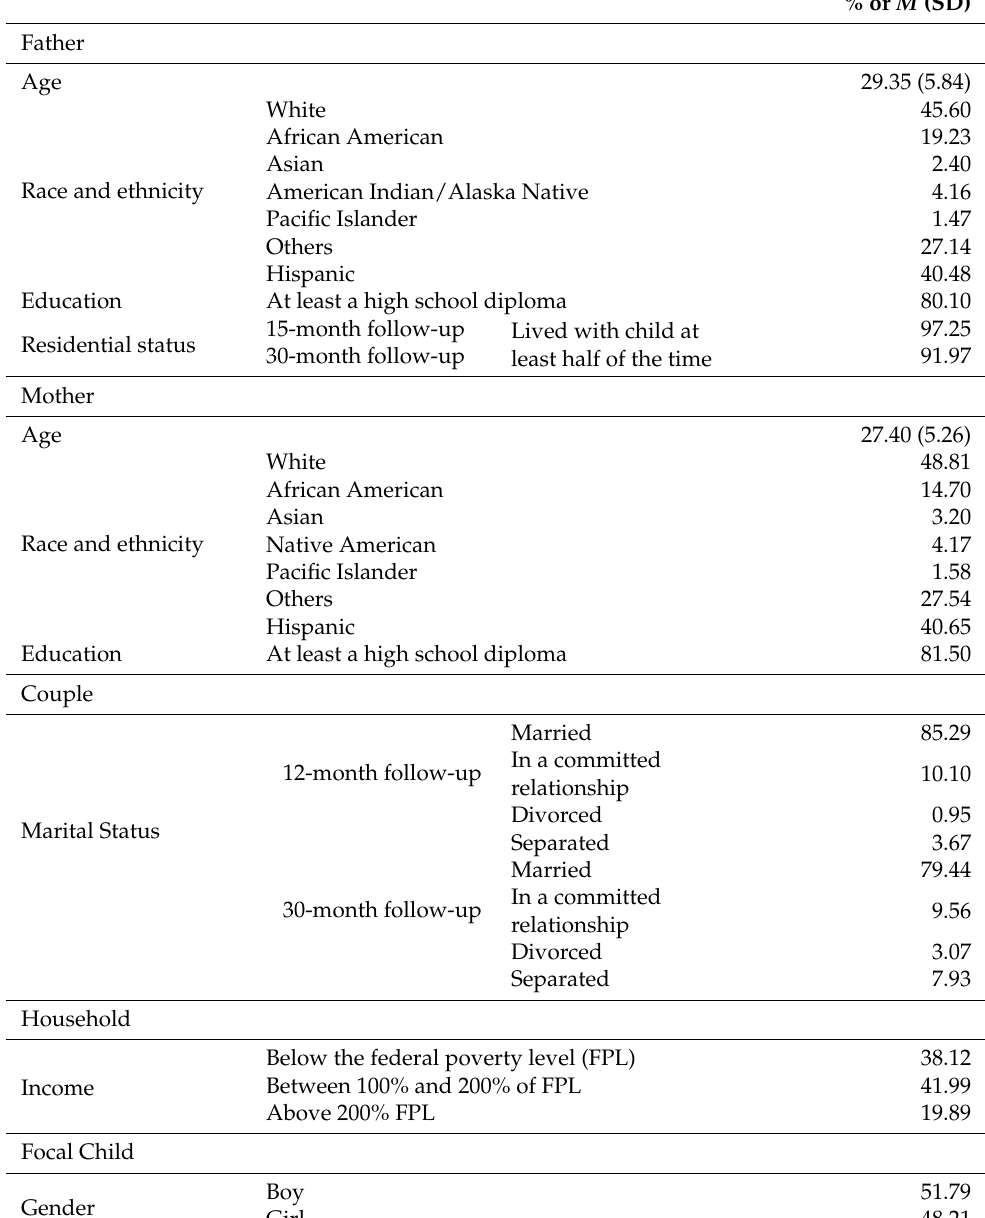
Table 1. Demographic Characteristics ( N =